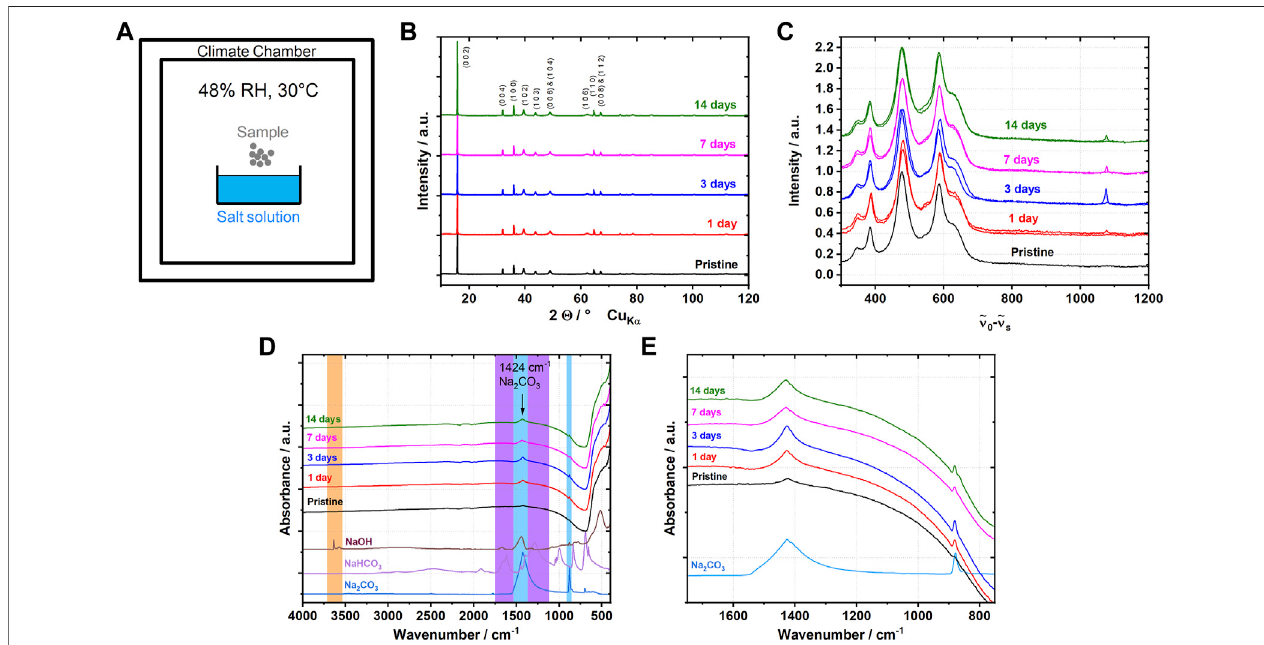
FIGURE 11 | (A) Schematic representation of model storage experiment, (B) XRD patterns of pristine and stored materials, (C) representative Raman spectra of pristine and stored materials, (D) ATR-FTIR spectra of pristine, stored and reference materials and (E) zoom-in into ATR-FTIR spectra.